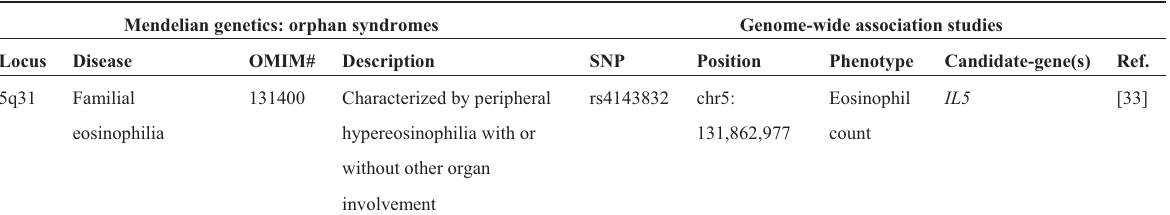
Table 3. Orphan human syndromes mapped to a chromosomal band and characterized by a blood cell phenotype. Only such syndromes that overlap with a locus identified by GWAS for the corresponding blood cell trait are included in this table. We generated this list by querying the Online Mendelian Inheritance in Man (OMIM) database with the